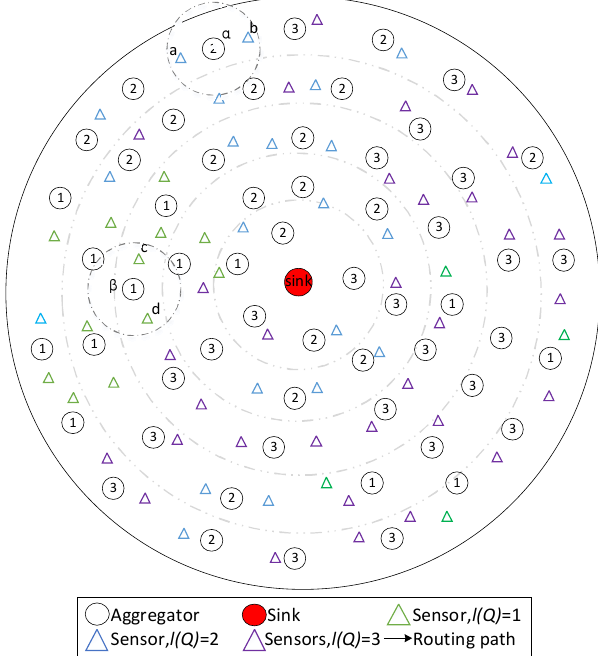
Figure 6. The sample operations in phase 1 of DDAR.